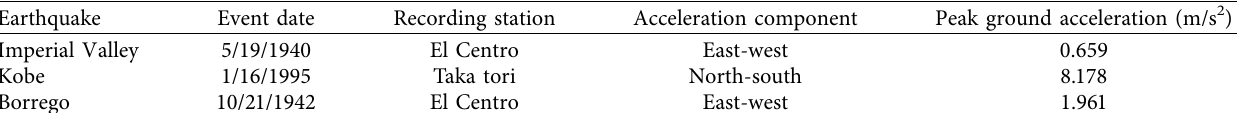
Figure 16: The acceleration envelope diagram of the bridge. Table 4: Seismic records.